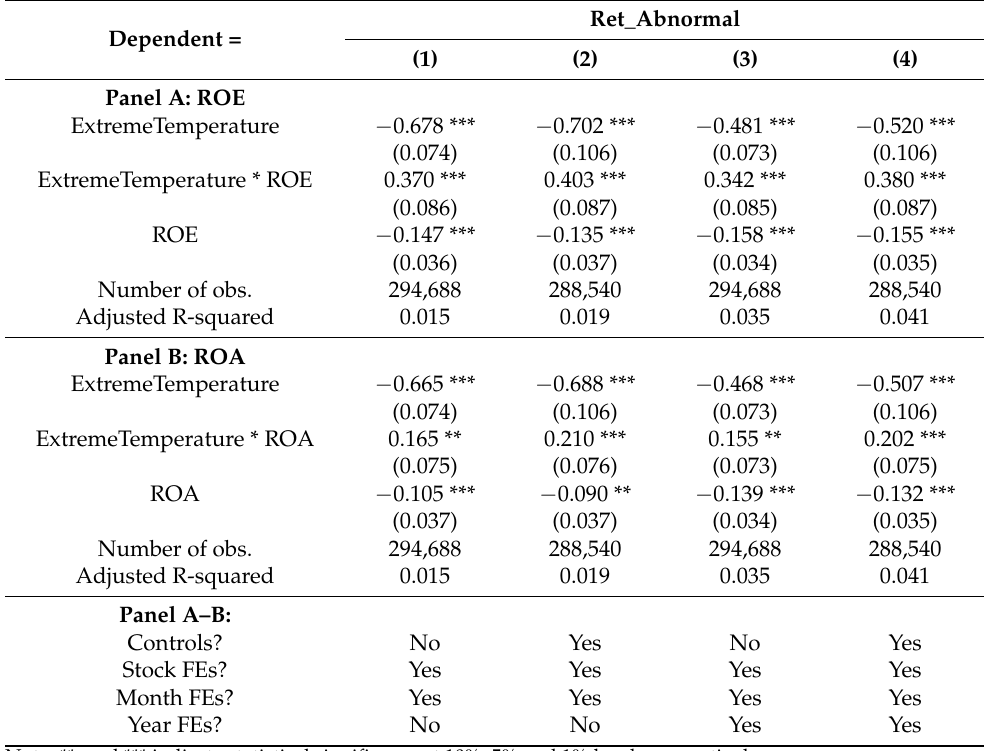
Table 5. The impact of extreme temperature across profitability